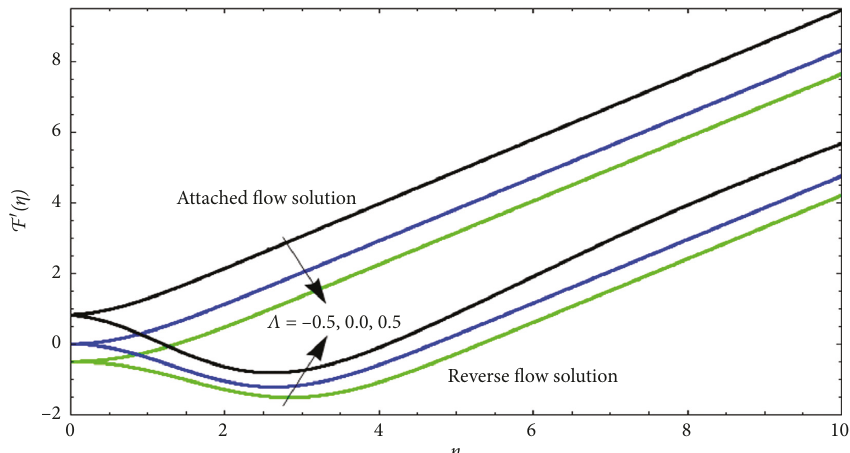
Figure 6: Dissimilarity of F ′ ( η ) being some different values of Λ for two solutions AFS and RFS.